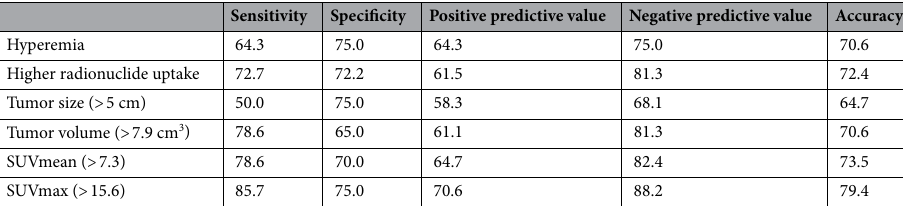
Table 4. Diagnostic performance in differentiating enchondroma and grade I